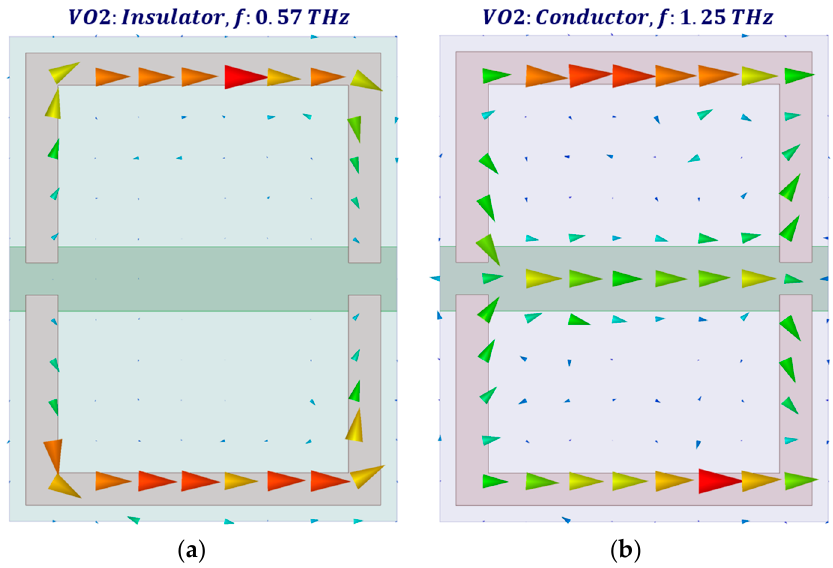
Figure 3. Surface current density of the double-split rectangular metamaterial with an aspect ratio of 1.25 operating in mode 1, ( a ) insulator phase (f = 0.57 THz ) , ( b ) conductor phase (f = 1.25 THz ) .